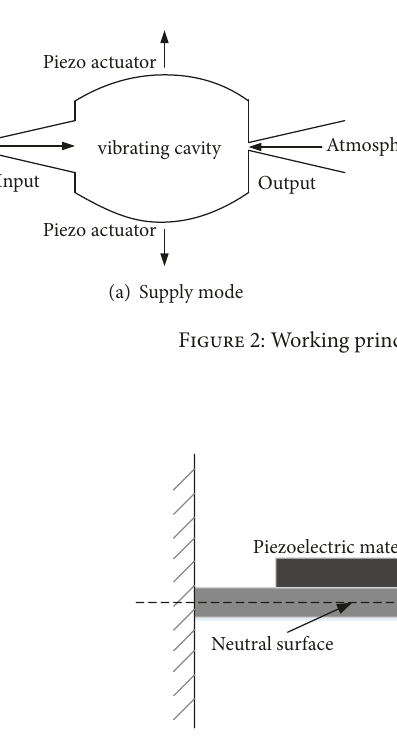
Figure 3: Schematic diagram of a unimorph circular piezoelectric actuator.